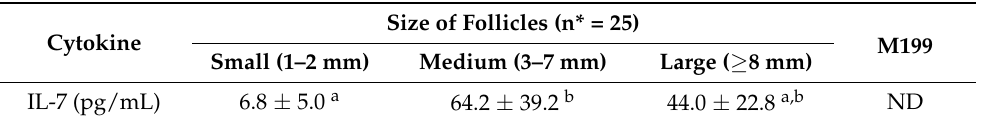
Table 1. The concentration of interleukin-7 (IL-7) in porcine follicular fluids from different follicle sizes (small, medium, and